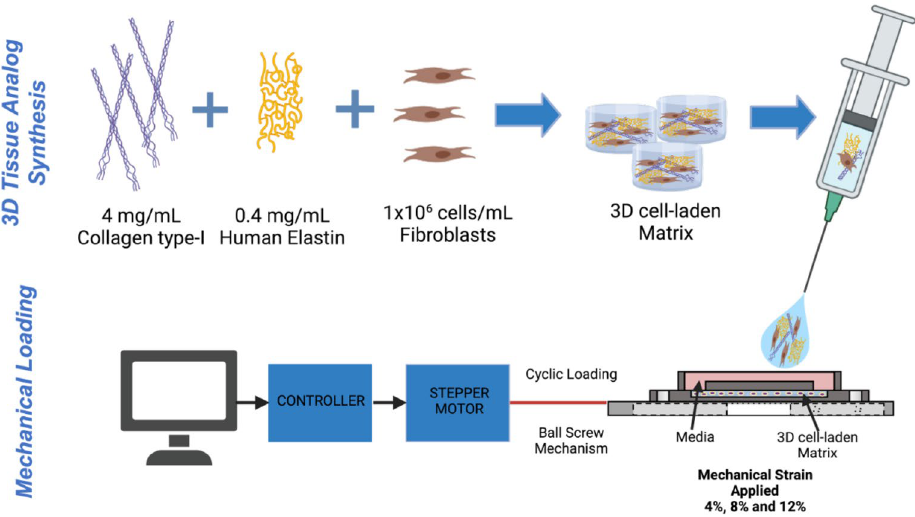
Figure 1. Schematic representation of cell-laden 3D tissue analogue synthesis and mechanical loading platform of cell-laden construct. “Created with www. Biore nder.